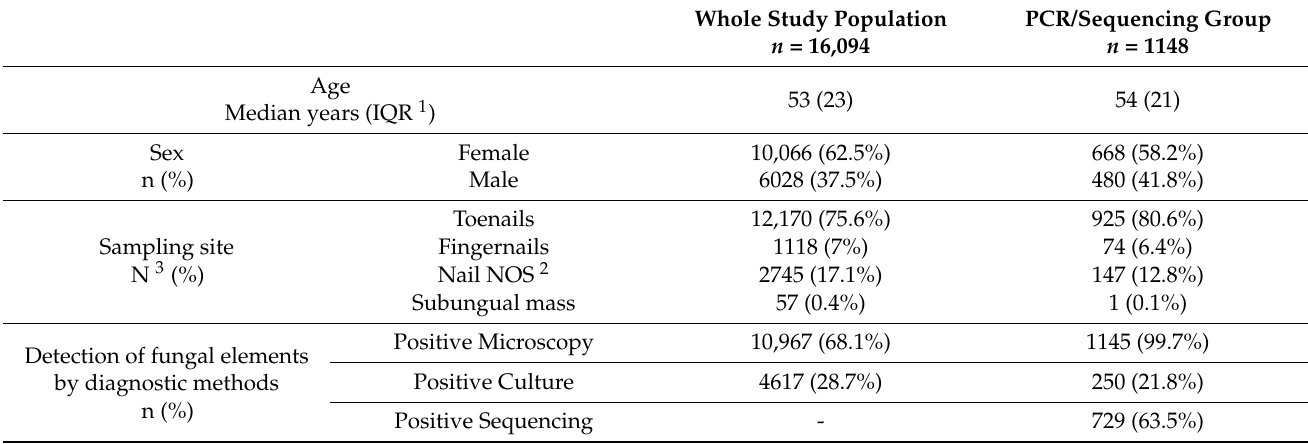
Table 1. Characteristics of the whole study population and PCR/sequencing group. Whole Study